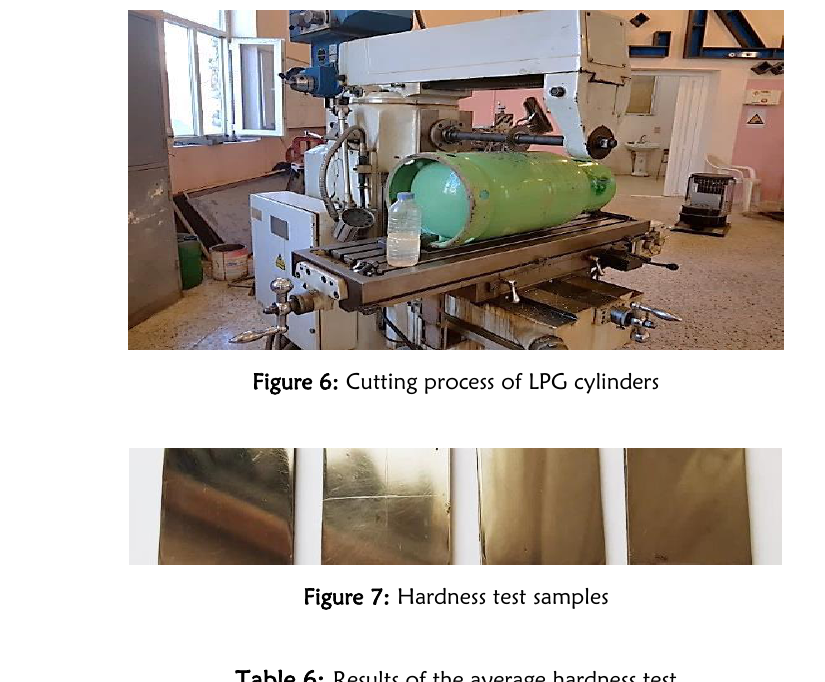
Table 6: Results of the average hardness